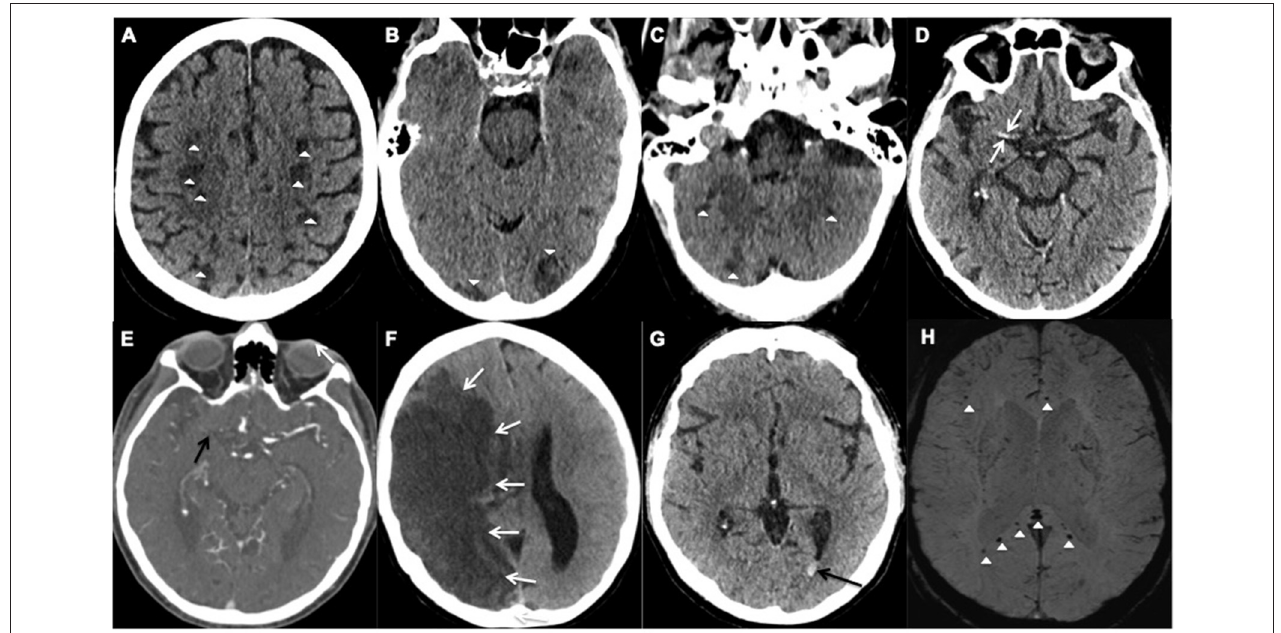
FIGURE 1 | Representative examples of cerebrovascular events; (A–F) acute ischemic stroke and (G,H) hemorrhagic events. (A–C) Axial unenhanced CT images of Patient 28 demonstrate multifocal infarcts (white arrowheads) bilaterally along the (A) centrum semiovale, (B) Occipital lobes, and (C) Cerebellar hemispheres. (D,E) Axial CT images of Patient 25 demonstrates the (D) hyperdense right middle cerebral artery (MCA) sign (white arrows) and (E) corresponding filling defect on the CT angiogram confirming an occlusive thrombus (black arrow). (F) Axial unenhanced CT image of Patient 6 shows a large right MCA territory infarct (white arrows) with mass effect in keeping with an MCA malignant syndrome. (G,H) Axial images of Patient 18. (G) unenhanced CT demonstrates hyperdense layering in the occipital horn of the left lateral ventricle (black arrow) in keeping with isolated intraventricular hemorrhage (IVH), (H) Susceptibility weighted imaging confirms the IVH bleed within the left occipital horn (white arrow) and shows microbleeds at the splenium and genu of the corpus callosum, and subcortical white matter (white arrowheads).